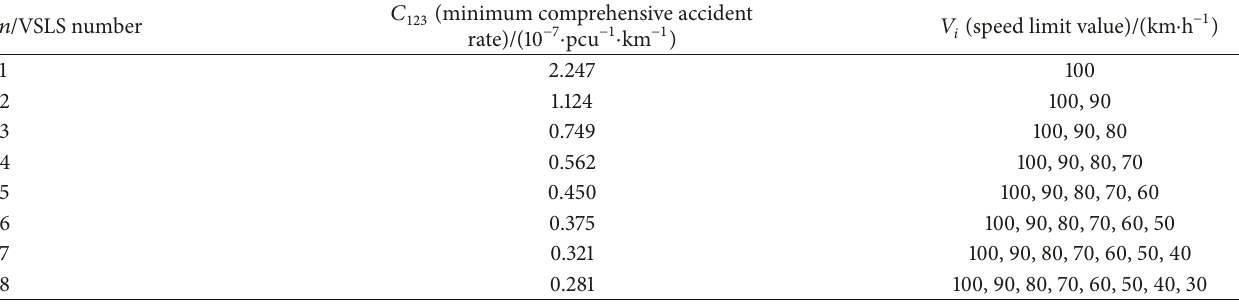
Table 1: Result of minimum comprehensive accident rate model.